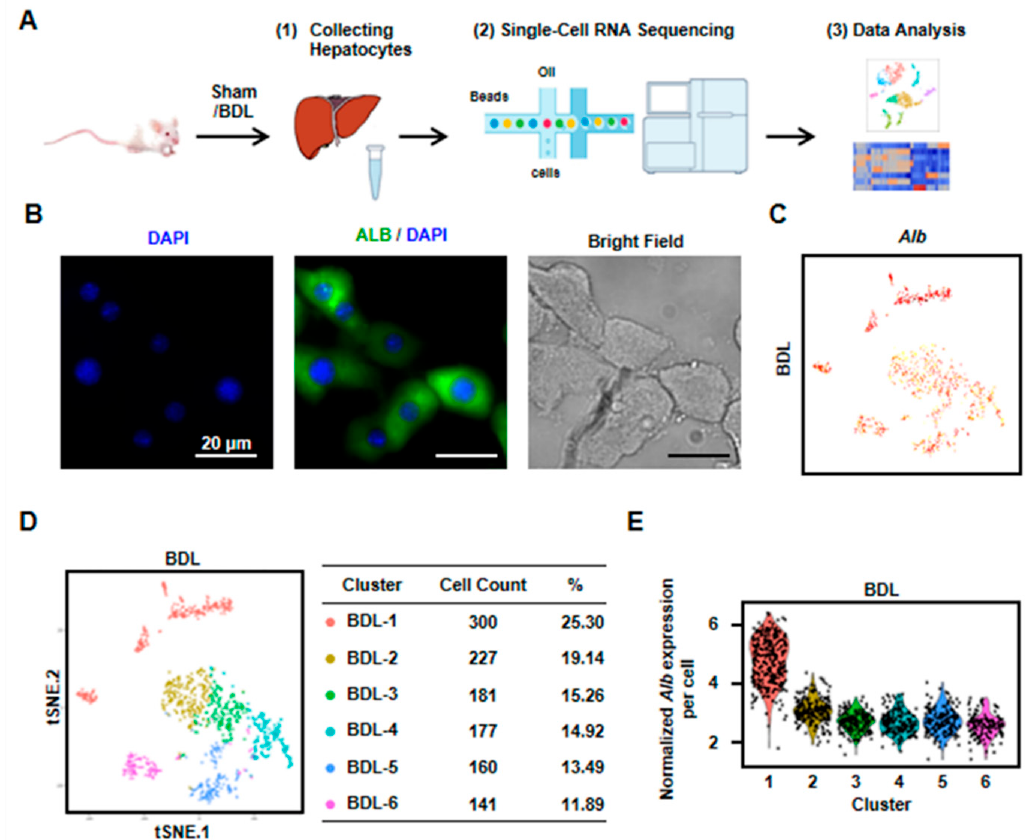
Figure 1. Six clusters were classified of cholestatic hepatocytes depending on scRNA-seq analysis. ( A ) Workflow depicts isolation of hepatocytes from liver for generating scRNA transcriptome profiles. ( B ) The staining of albumin (Alb) on isolated cholestatic hepatocyte smear. Scale bars, 20 µ m. ( C ) The expressions of Alb in all cells were shown. ( D ) 2D visualization of single-cell clustering of hepatocytes profiles inferred from RNA-seq data. Six major classes of hepatocytes in injured liver were detected. The count of each cell population was indicated. Colored bar coded as indicated. ( E ) The expression of Alb in each cluster was shown.